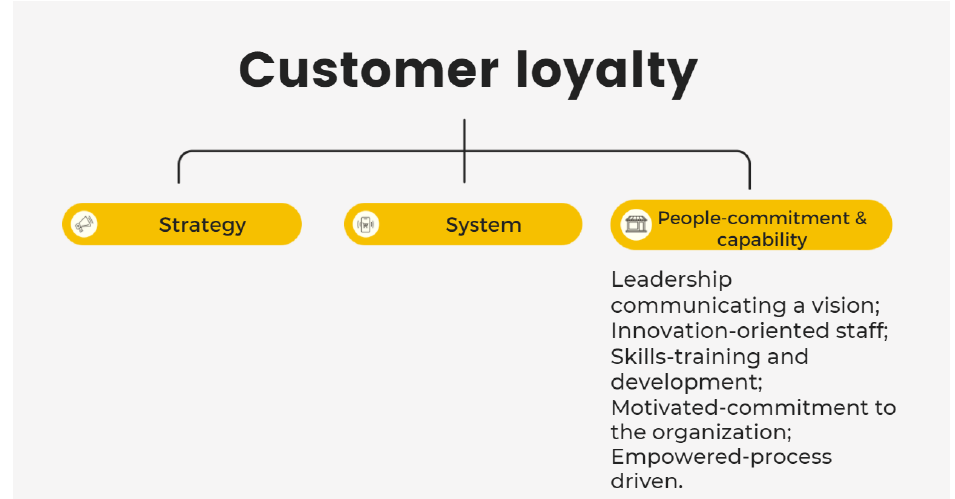
Figure 11. Market-led innovation: people-commitment and capability [18].